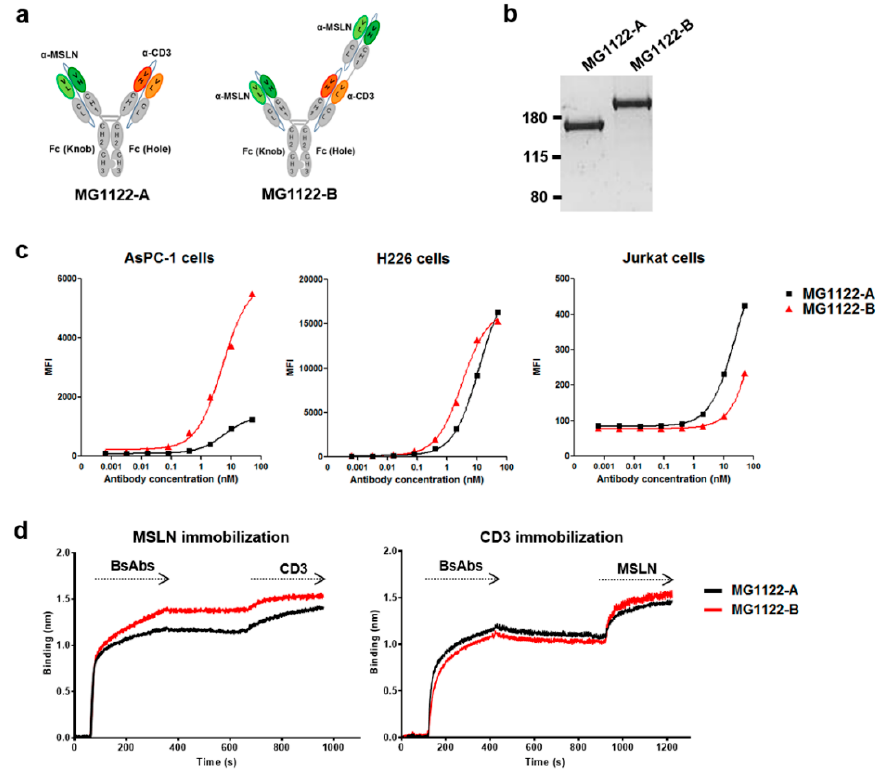
Figure 2. Structural features and binding of bispecific antibodies. ( a ) Structural characteristics of bispecific antibodies MG1122-A and MG1122-B. MG1122-A is an asymmetric IgG 1 -based human antibody against MSLN and CD3 ε . MG1122-B is an asymmetric two-arm IgG 1 human antibody, bivalent against MSLN and monovalent against CD3 ε . ( b ) Purity and molecular weight of the antibodies were assessed by SDS-PAGE analysis. ( c ) Specific binding of bispecific antibodies to MSLN in two MSLN-expressing cancer cell lines (AsPC-1 moderate and H226 high ) and to CD3 in the Jurkat cell line was evaluated by flow cytometry. ( d ) Dual antigen binding of bispecific antibodies to MSLN and CD3 was measured by the Octet system.